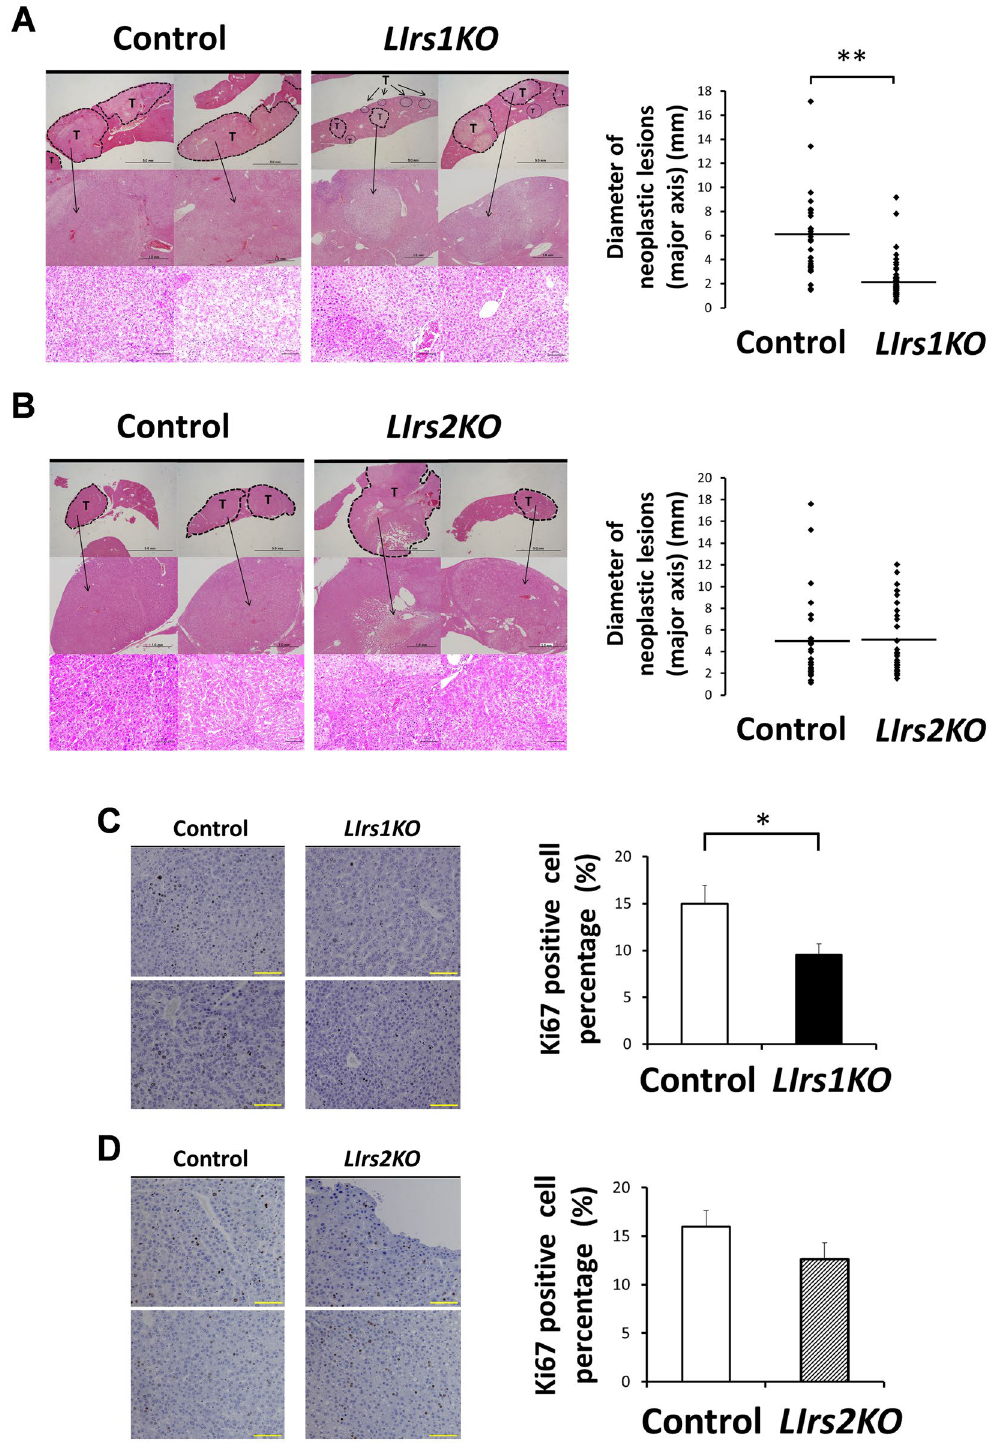
Figure 3. Loss of Irs1 in the hepatocytes decelerates tumor growth and proliferation. Ten months after DEN administration, histological analyses were performed. ( A and B ) Representative images of hematoxylin and eosin (H&E) staining (left) and diameter of neoplastic lesions (mm) (major axis)/field (right) in the livers from each DEN-treated mouse group (11–16 mice in each group). T, tumor lesion. Scale bar, 5 mm, 1 mm, 100 μ m, in order from the top. ( C and D ) Representative images of Ki67 immunostaining (left) and the percentage of Ki67 positive cells in neoplastic lesions in the livers from each DEN-treated mouse group (right). Scale bar, 100 μ m. Values are the means ± SEM of data obtained from the analysis of each group (n = 11–12). * P < 0.05. ** P <